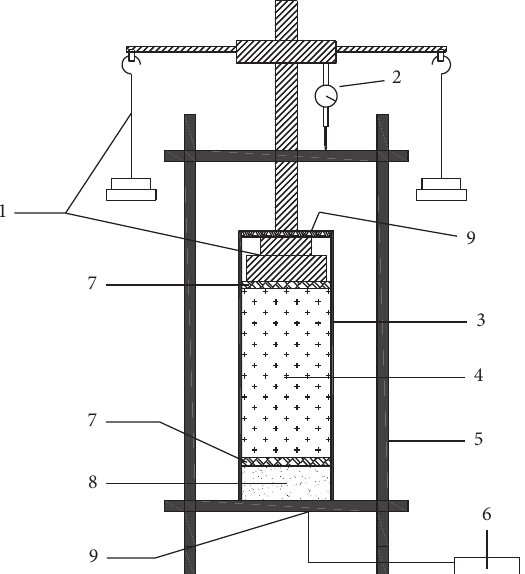
Figure 5: One-dimensional biodegradable compression instrument.1, loading device; 2, measuring device; 3, sample container; 4, sample; 5, instrument support; 6, leachate collection device; 7, permeable stone; 8, sand layer; 9, sealing